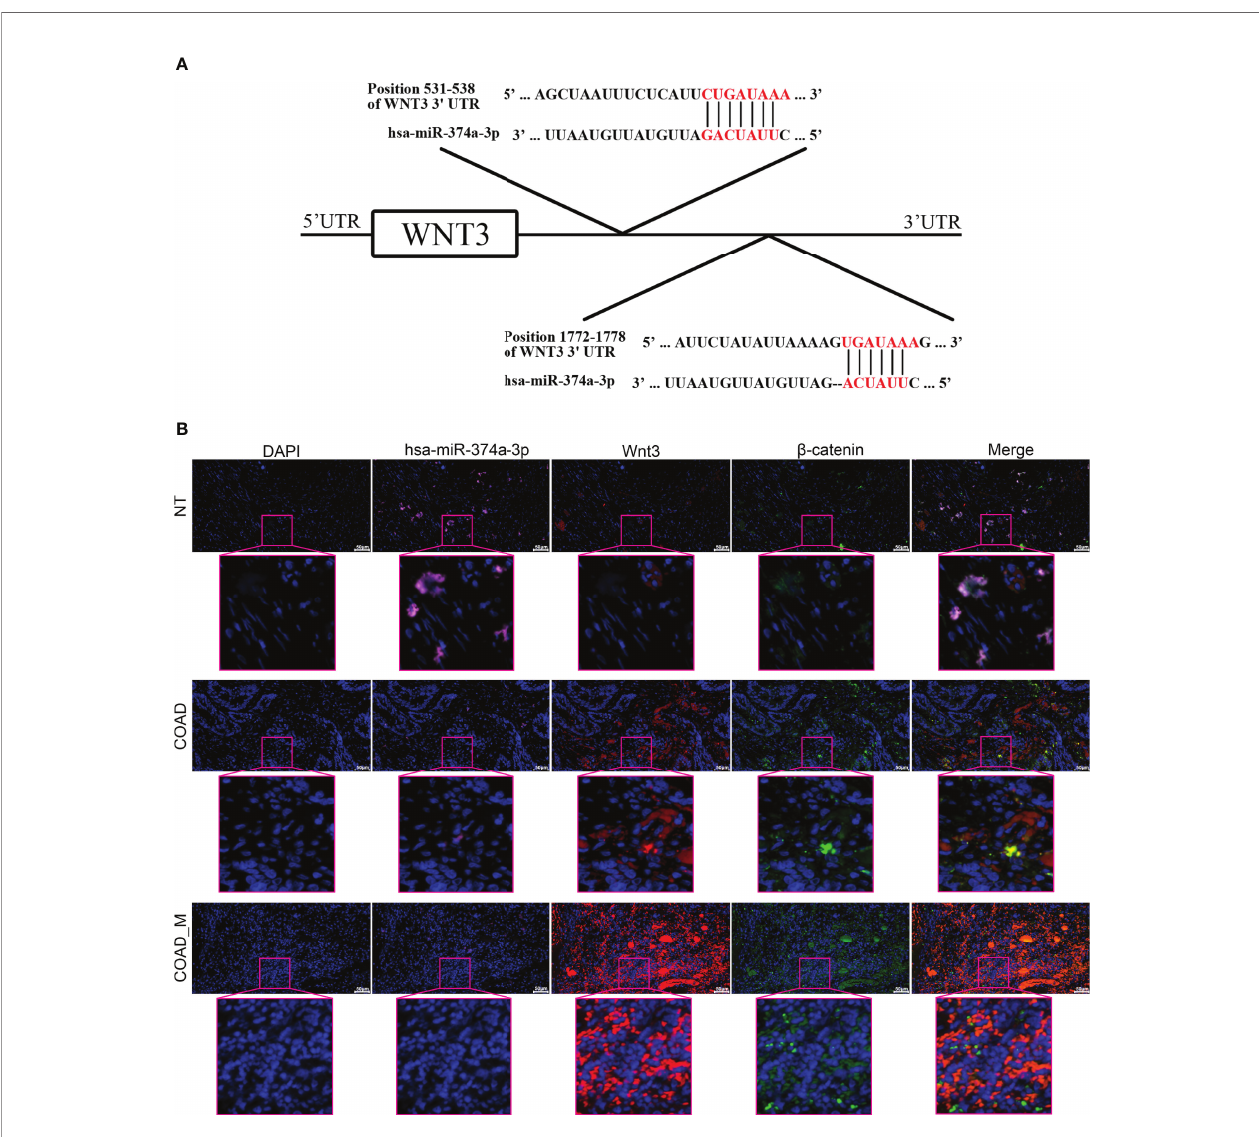
FIGURE 3 | WNT3 is potentially targeted by hsa-miR-374a-3p and expression of WNT3 is negatively linked to hsa-miR-374a-3p in COAD. (A) Feasible binding sites were predicted using the TargetScan Human 7.2 database. (B) Expression of hsa-miR-374a-3p, Wnt3, and b -catenin in COAD specimens was probed via FISH and immuno fl uorescence